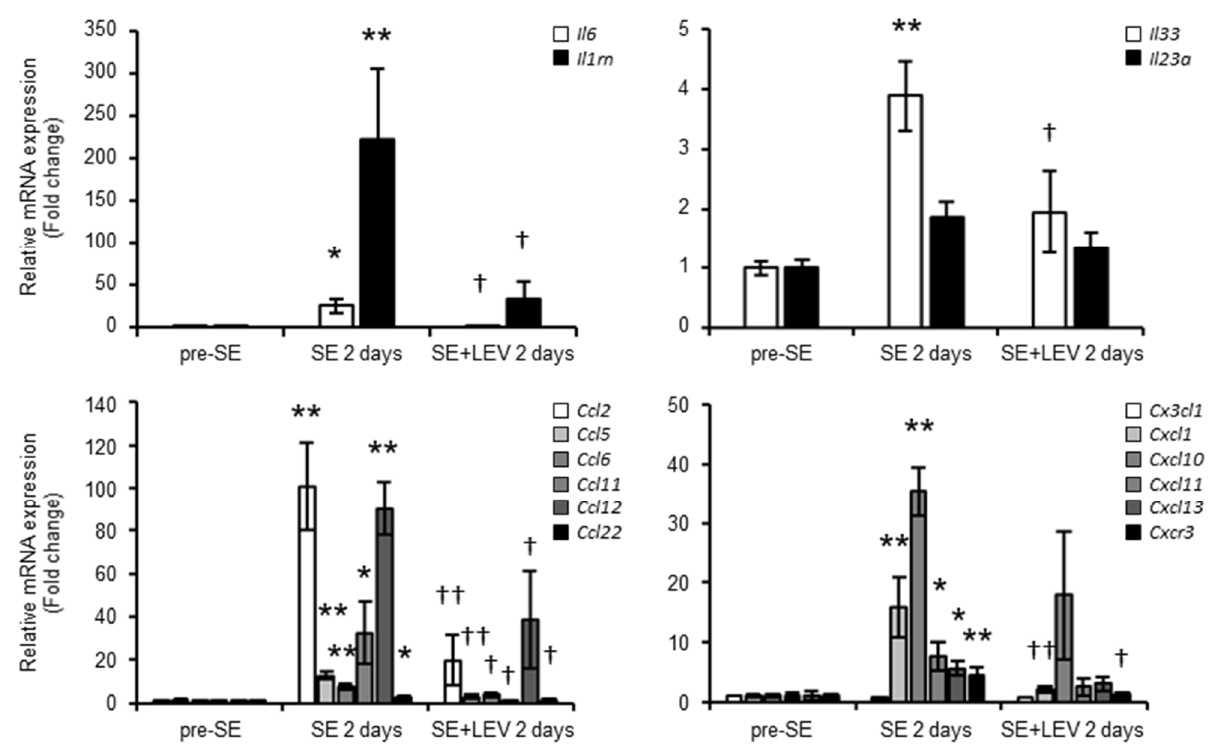
Figure 2. Real-time PCR analysis of the levels of typical cytokines/chemokines at 2 days after SE. Total RNA was extracted from the hippocampus before (pre-SE) and 2 days after SE (SE 2 days) in animals treated with LEV or that were untreated. Real-time PCR was performed using gene-specific primers as described in Table 1. All data points represent the mean ± SEM of at least three independent experiments ( n = 3–9). Data were analyzed for significant differences by one-way ANOVA and Tukey’s post-hoc test. Results with p values < 0.05 were considered statistically significant. ** p < Table 1. Primer sequences used for real-time PCR.